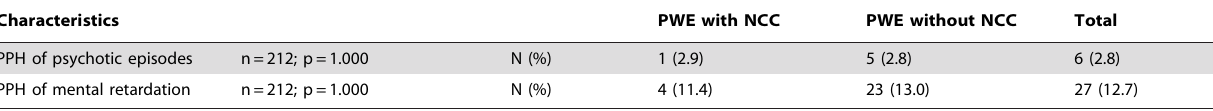
Table 2. Frequency of potential risk factors of neurocysticercosis in people with epilepsy with and without neurocysticercosis.